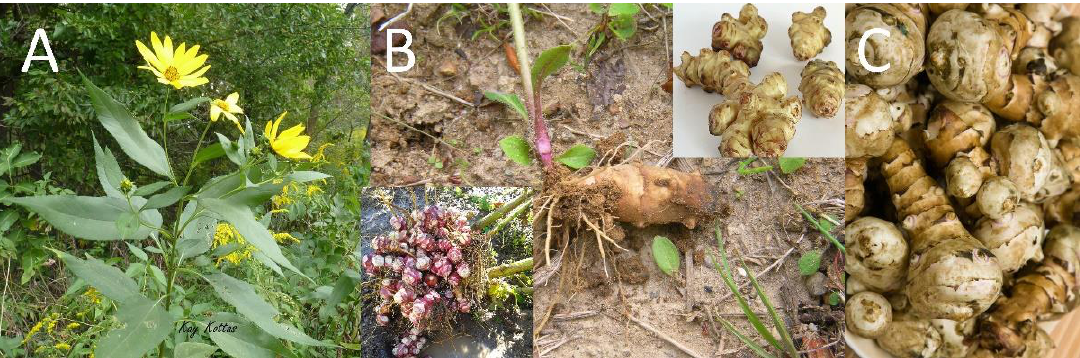
Figure 1. Jerusalem artichoke ( Helianthus tuberosus L.): ( A ) the whole plant, leaves, and flowers, ( B ) the rhizome system, and ( C ) tubers.